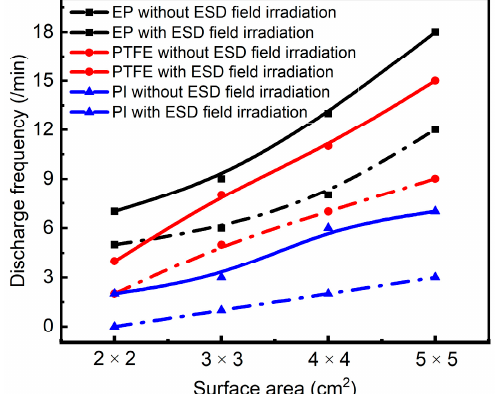
Figure 14 . Discharge conditions of dielectric films with different grounding areas with or without external field irradiation . external field